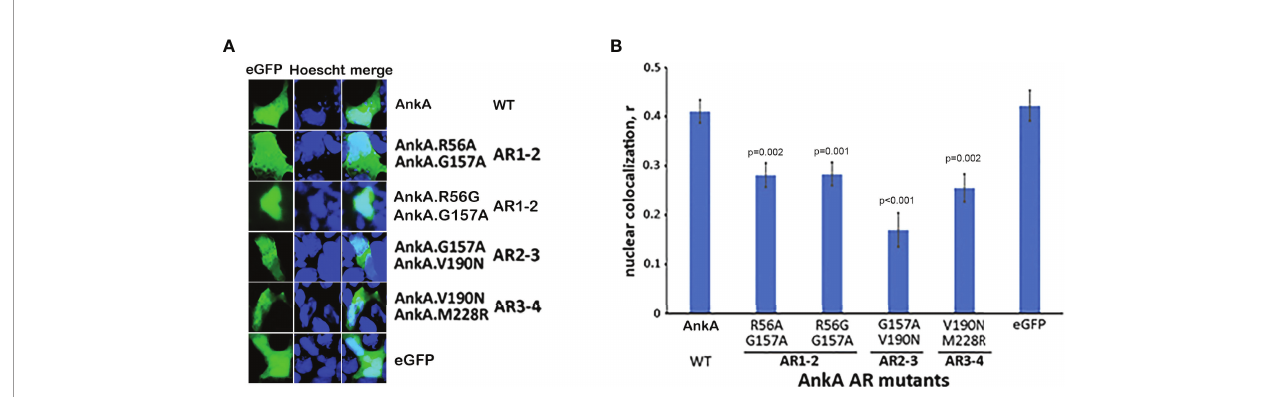
FIGURE 3 | Single mutations in two adjacent N-terminal ARs signi fi cantly reduce nuclear localization of AnkA. HEK293T cells were transfected with eGFP plasmid constructs of AnkA or AnkA AR mutants in which two neighboring ankyrin repeats 1 & 2, 2 & 3 or 3 & 4 (AR1-2, AR2-3, AR3-4) had a single amino acid replacement. After fi xing and washing, the cell nuclei were stained with Hoescht33342 and visualized with fl uorescent microscopy. (A) Representative images of cells with eGFP- AnkA and dual-mutated ankyrin repeats are shown. (B) Nuclear colocalization of AnkA and mutants were determined by using the colocalization module of Olympus CellSense software. Data shown are mean ± SEM of Pearson correlation coef fi cient, r, from 20-40 ROIs containing 100-200 transfected cells of two independent experiments in duplicate. ANOVA post hoc Bonferroni corrected p values <0.05 relative to wild type AnkA are shown. Bar-20 µm.